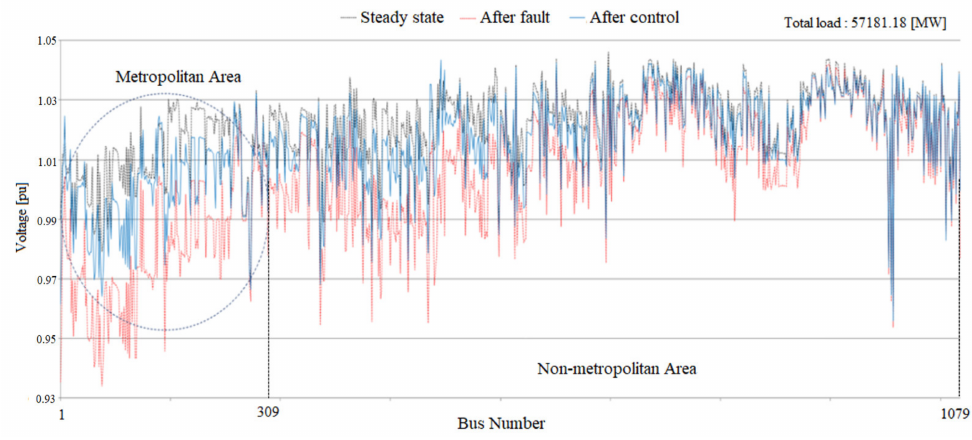
Figure 6. Voltage profile of all buses in the Korean power